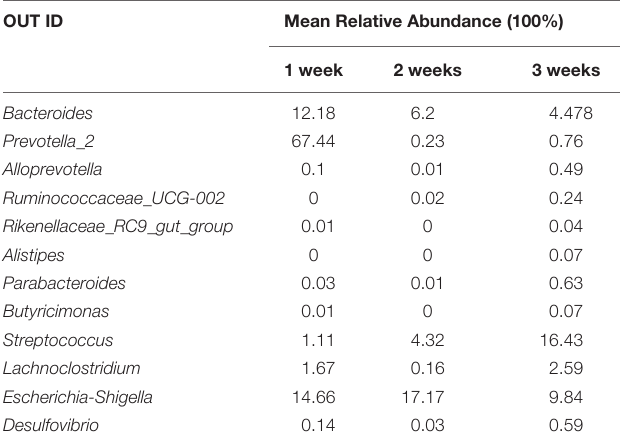
TABLE 2 | Dynamic changes of 12 core genera content in PEDV-infected piglets. OUT